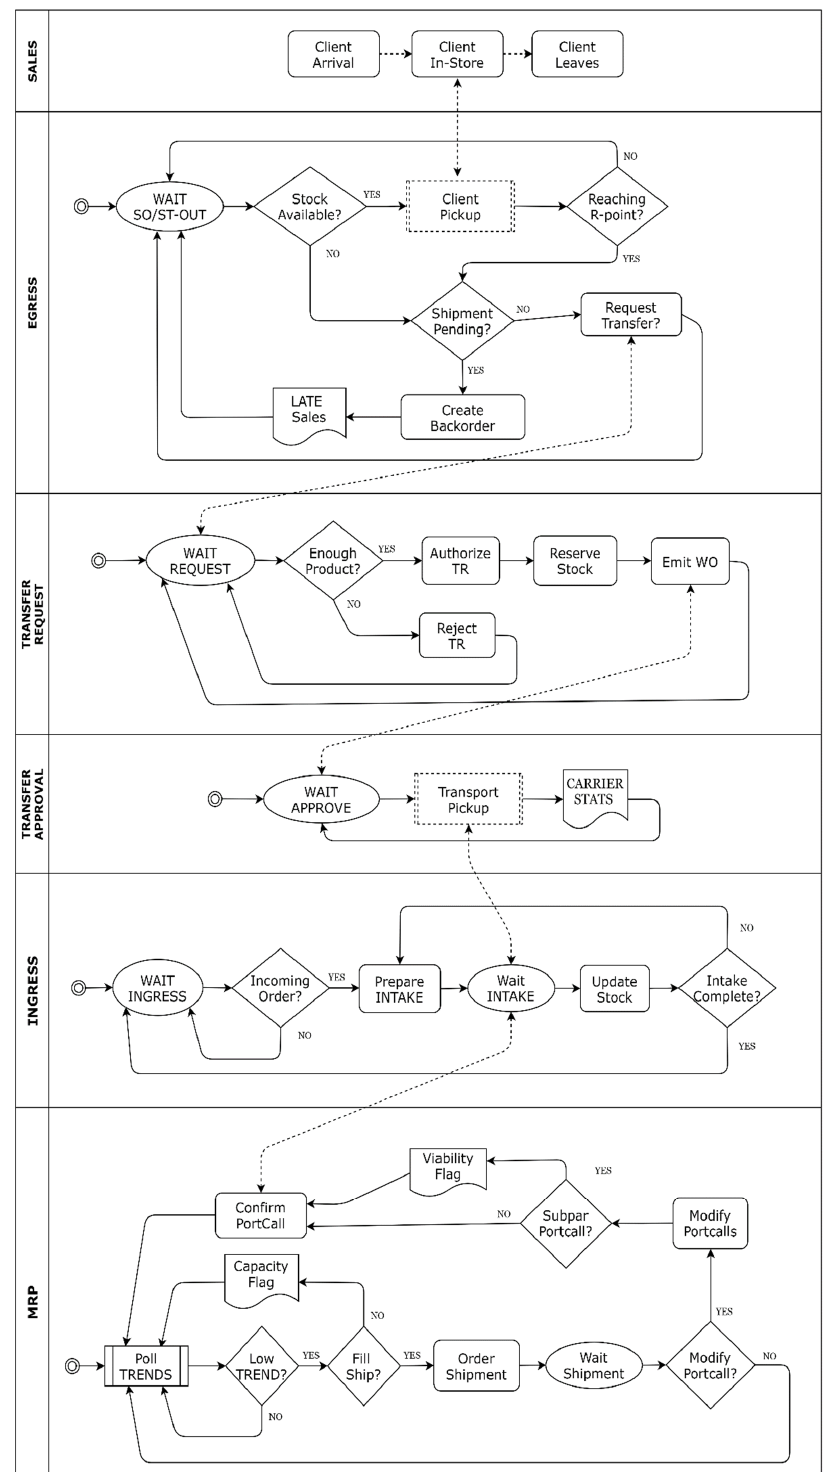
Figure 19. Conceptual Model—Operations Plane (CM-O) represented in swim lane form. We developed the CM-O with our own symbols. Optionally BPMN notation could have been